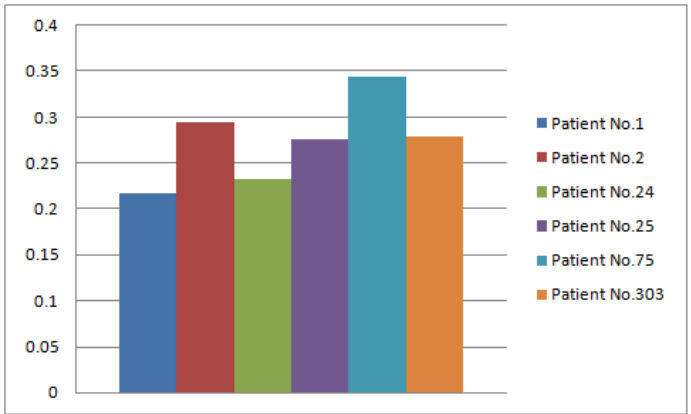
D 1 ∆ for each ˆ p i